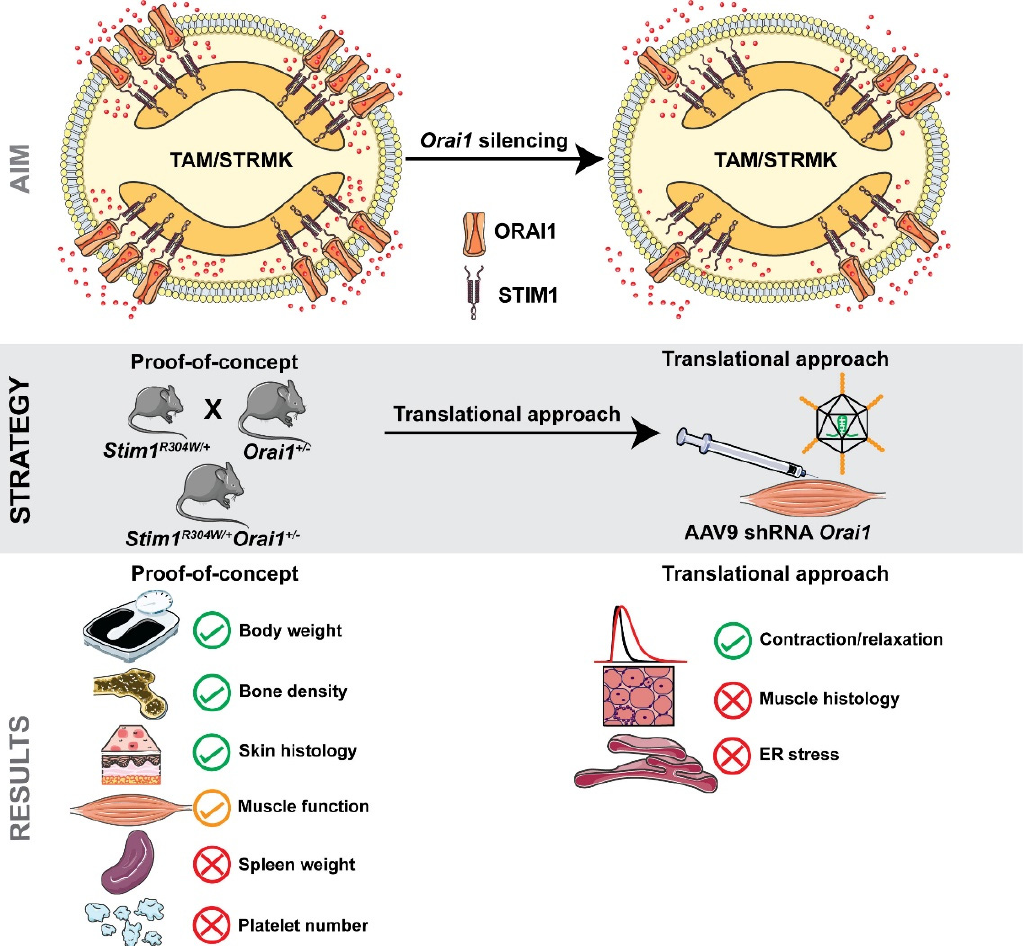
Figure 5. Graphical overview. Illustration of the aim, experimental strategy, and main results of the present study.